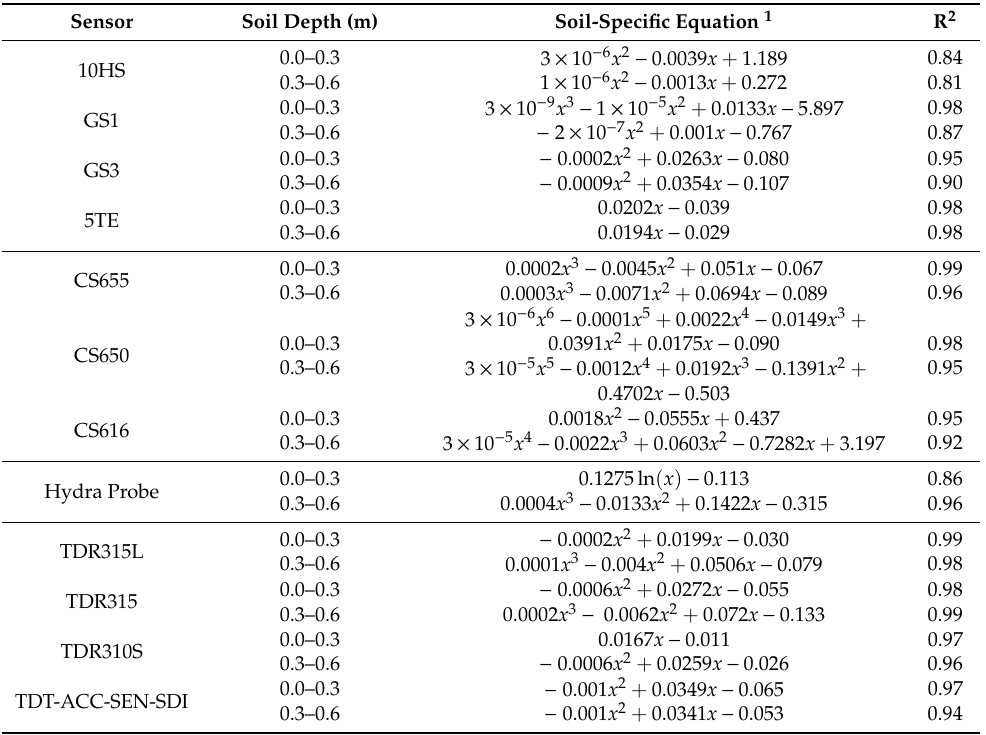
Table 5. Soil-specific calibration equations for commercial soil moisture sensors in the Riviera soil